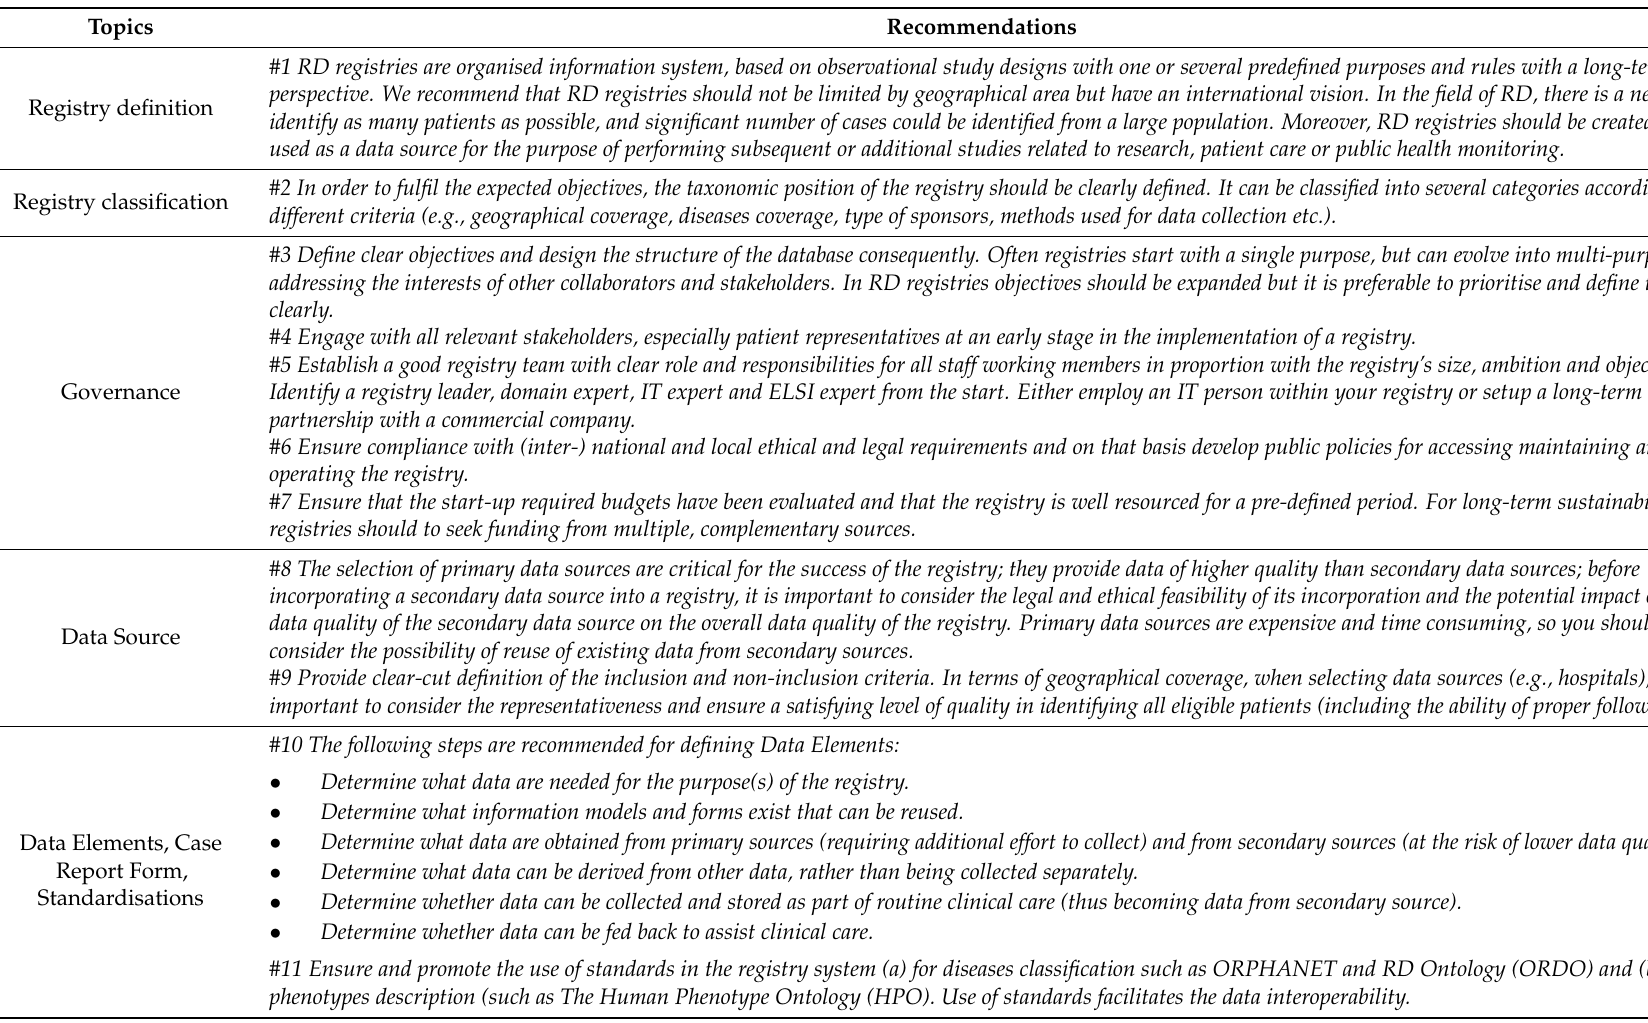
Table 2. List of recommendations for Improving the Quality of Rare Disease